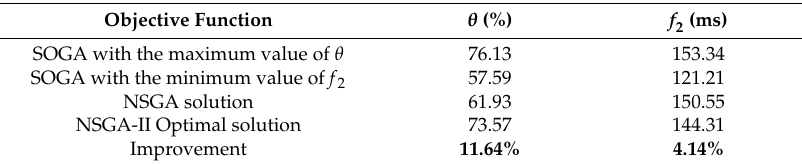
Table 5. Comparison of NSGA-II with other genetic algorithm in AB-Graph partition problem.